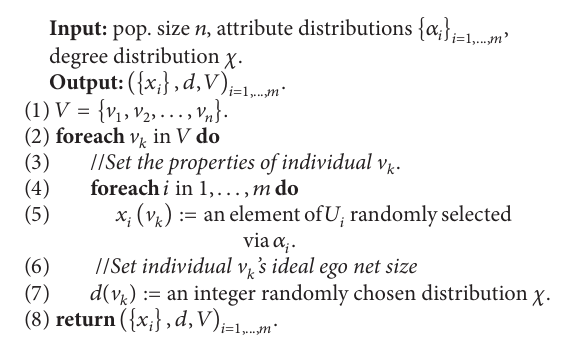
Table 5: DegreeBinned univariate 𝜒